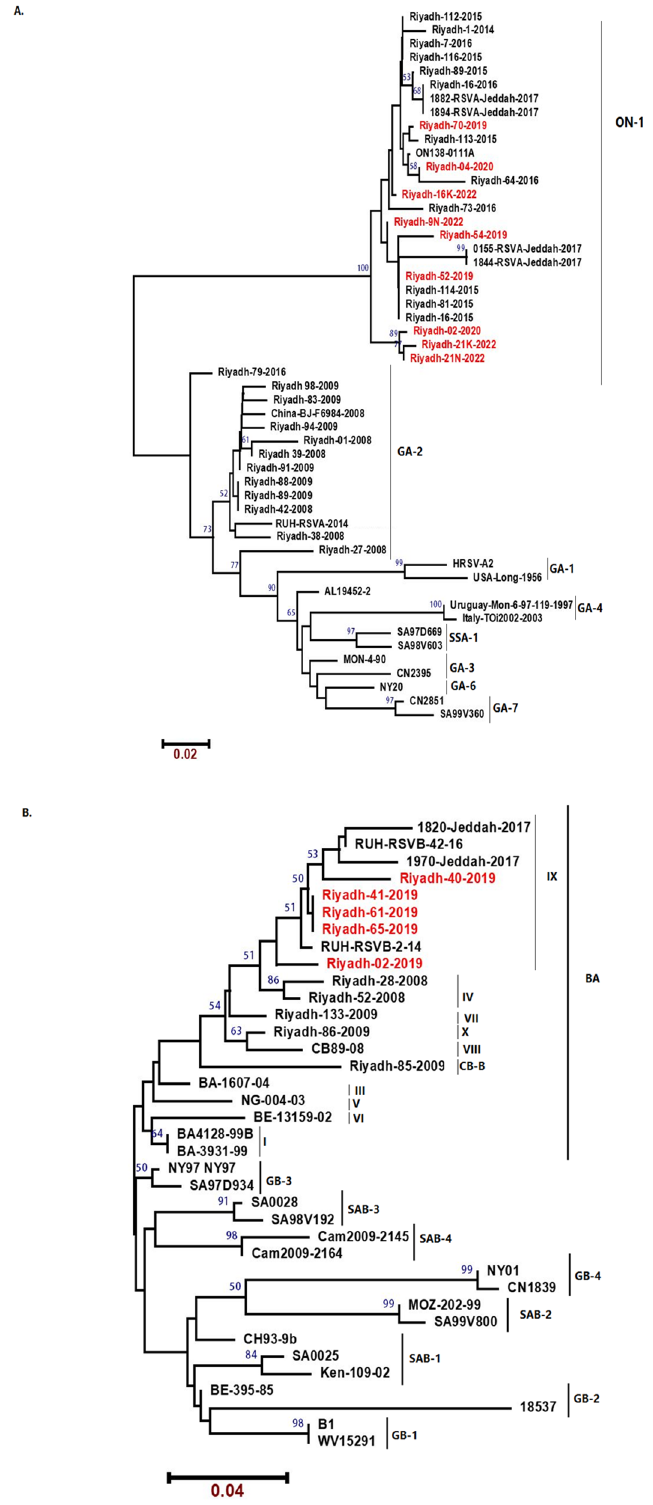
Figure 1. Phylogenetic trees for HOPV group A ( A ) and group B ( B ). The 270 base nucleotide sequences of the C-terminal fragment of the 2nd HVR of the G protein gene were used for alignment. The phylogeny tree was created using the neighbor-joining method using MEGA11 program. The numbers at the internal nodes of the tree represent the bootstrap values of 1000 replicates. Only values exceeding 60% are shown. Strains of seasons 2019/2020 and 2021/2022 are denoted by red.